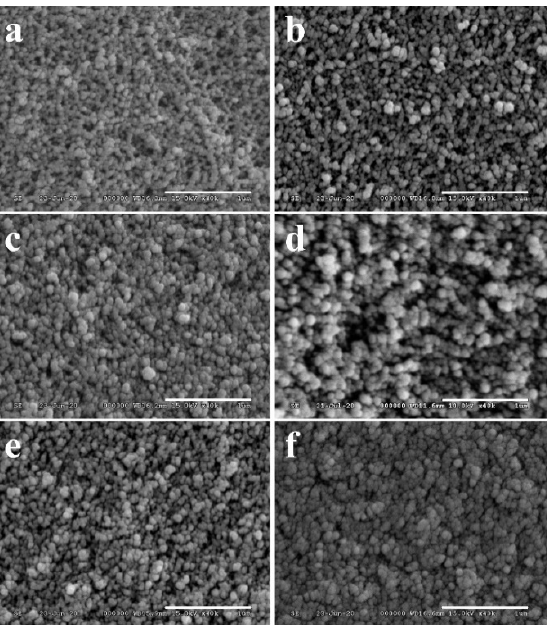
Figure 3. Scanning electron microscopy images of the structure of aerogel matrices in the composites calcined at different temperatures: ( a ) 500 °C; ( b ) 600 °C; ( c ) 700 °C; ( d ) 800 °C; ( e ) 900 °C; ( f ) 1000 °C. Scale bars: 1 μ m.